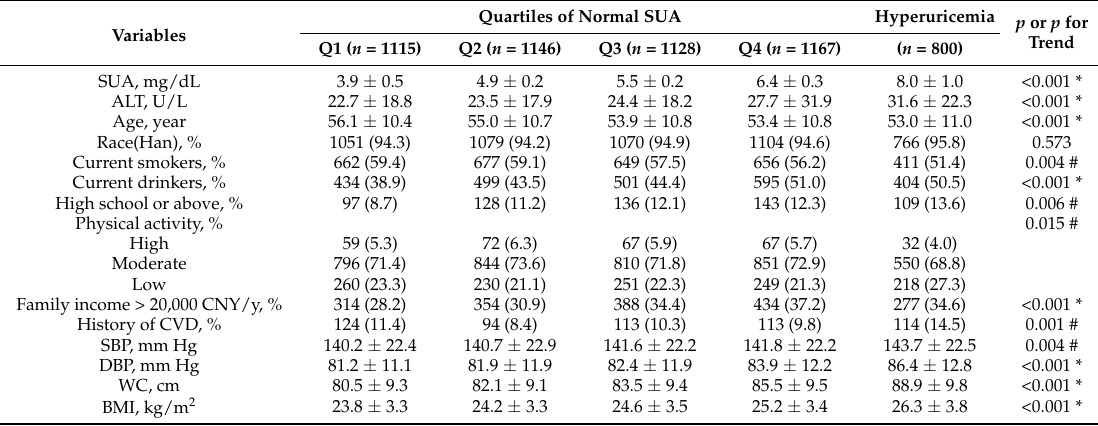
Table 1. Characteristics of subjects according to serum uric acid level in men ( n = 5356).